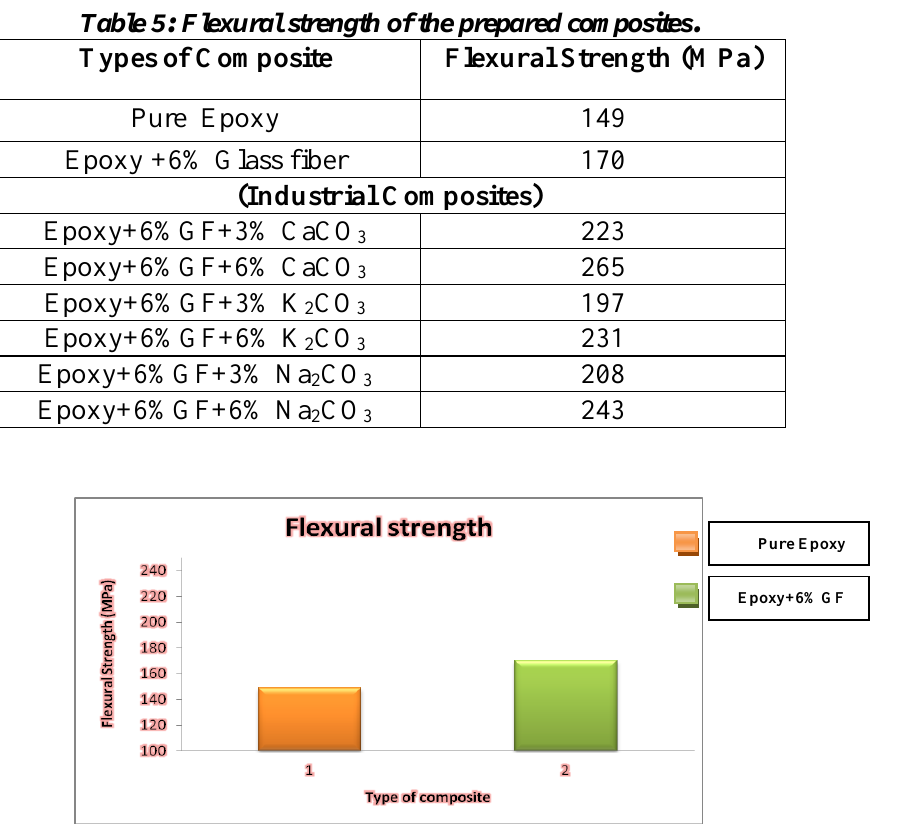
Fig.14: Flexural strength of Epoxy +6% glass fiber composites and pure epoxy.